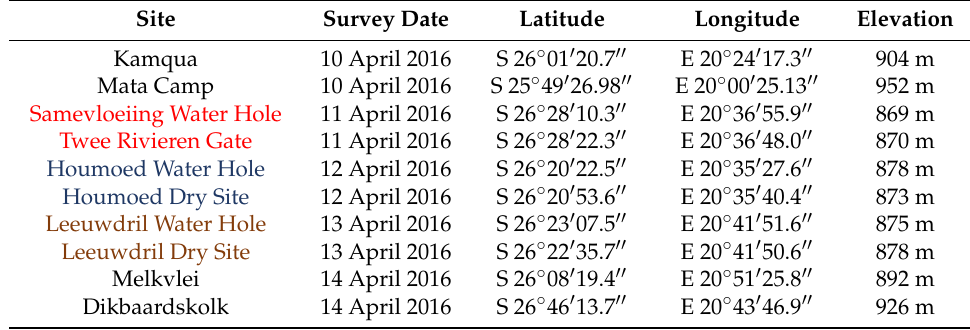
Table 1. Site specific data for sonar surveys, including survey date, latitude, longitude, and elevation. Colors indicate sites paired as dry and